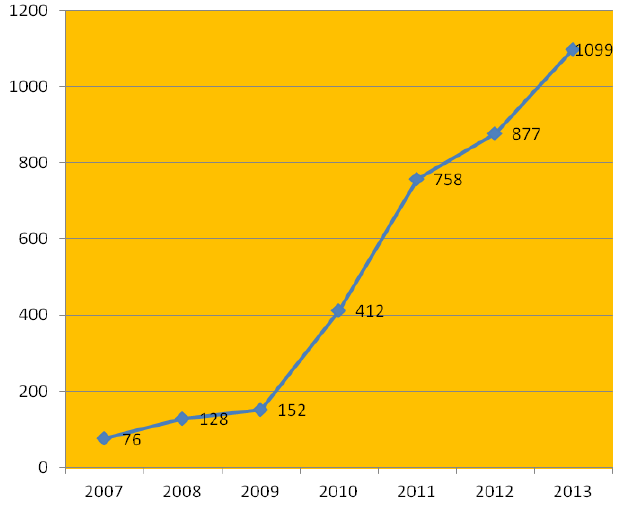
Figure 7. Number of contaminated areas enrolled in the health program, 2007–2013 (Source: Division of Diseases Caused by Environment—DOMA/CVE).